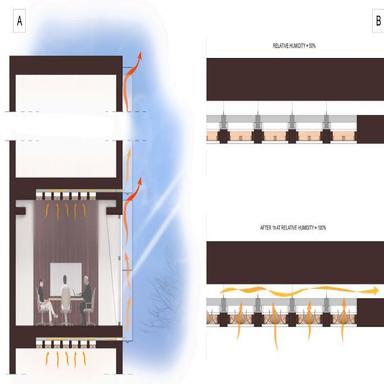
A: Bioclimatic cross-section of the meeting room. Humid and warm air leaves the inside, thanks to the convective motion; B: The modular panels are closed if the relative humidity is ≈ 50% and open if it is higher, enabling the ventilation.